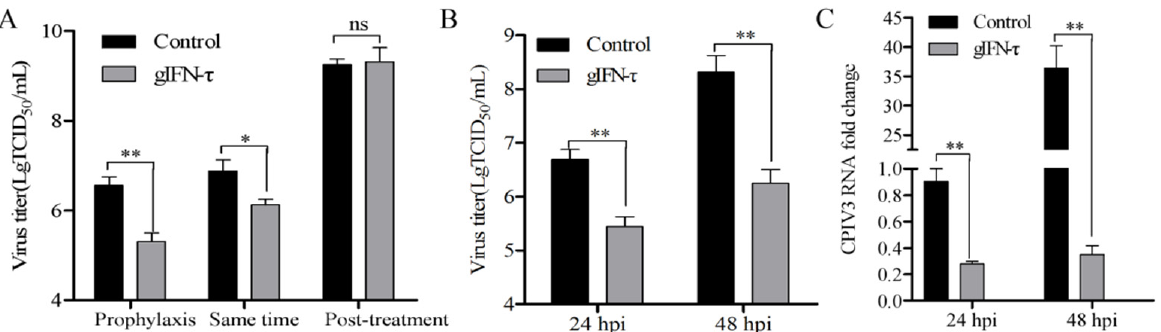
Figure 5. Goat IFN- τ inhibits CPIV3 infection in MDBK cells. ( A ) Goat IFN- τ prophylaxis but not treatment modulates CPIV3 infection in MDBK cells. MDBK cells were treated with goat IFN- τ (1 μ g/mL) 24 h before infection or together with infection, and then the samples were harvested at 24 hpi. MDBK cells were treated with goat IFN- τ (1 μ g/mL) 48 h after infection, and the samples were